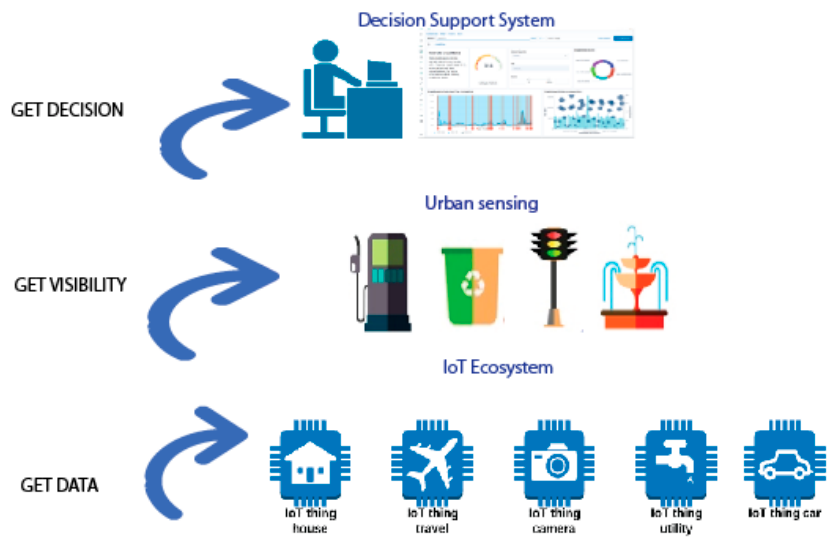
Figure 22. Three-phase cycle to generate intelligence for data decision.